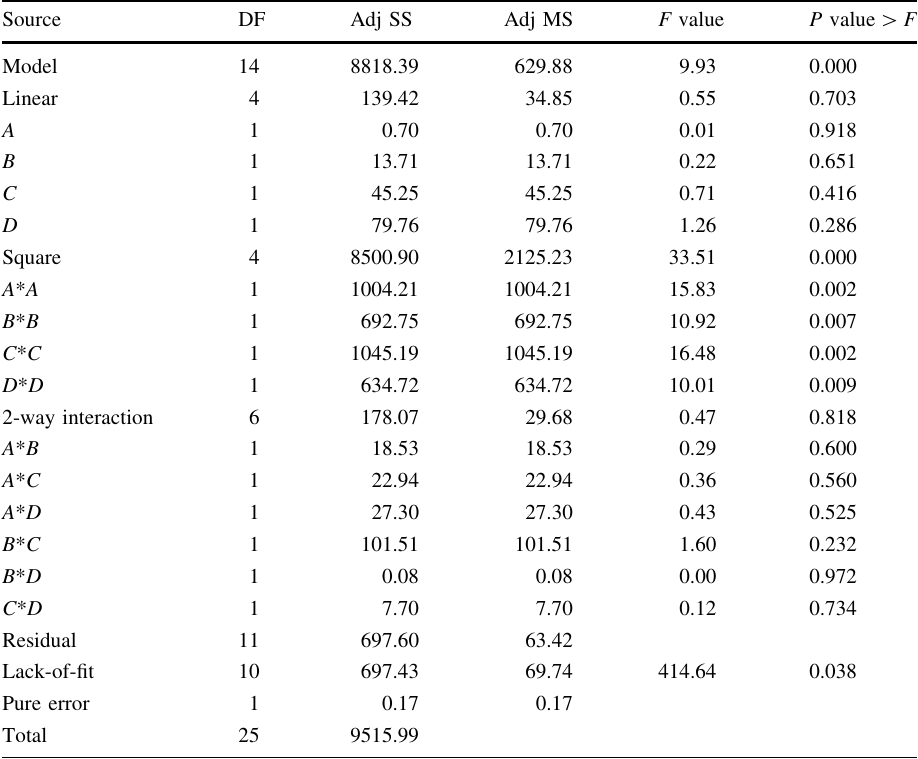
Table 4 Analysis of variance for %